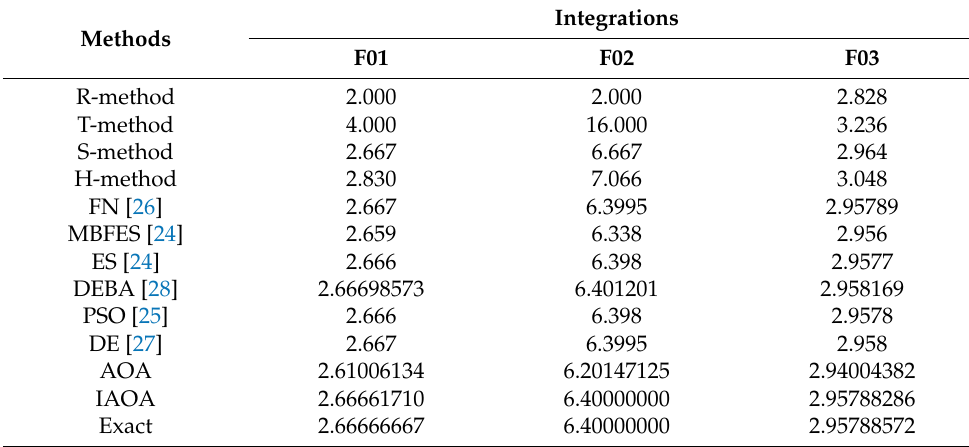
Table 9. Comparison of the experimental results for